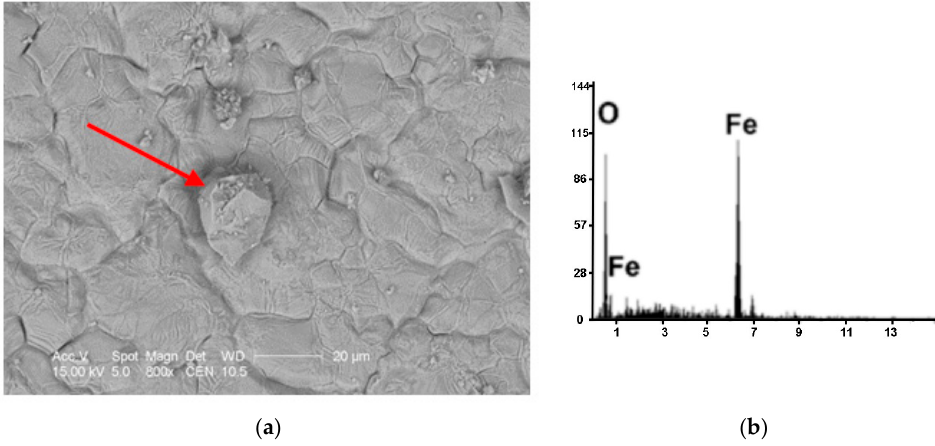
Figure 1. Scale dust (No. 7): ( a ) Scanning electron microscopy (SEM) image of the magnetite crystal (indicated with red arrow); ( b ) the EDS spectrum.